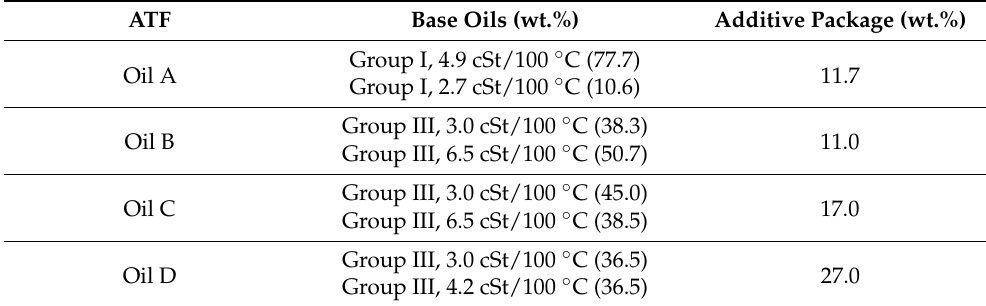
Table 1. Composition of the